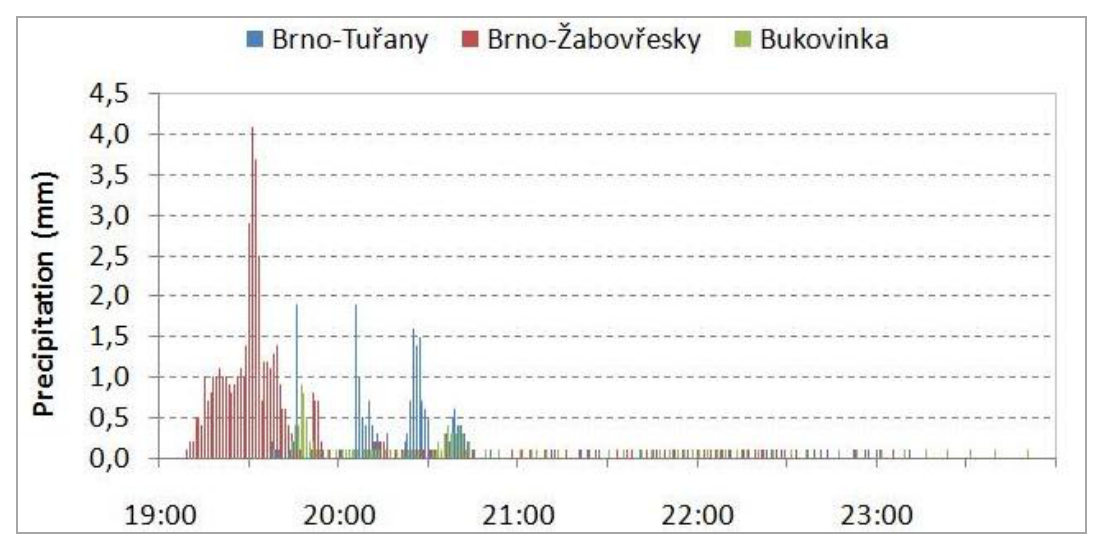
Fig. 2. The course of precipitation in Brno region on July 15, 2009 at minute intervals